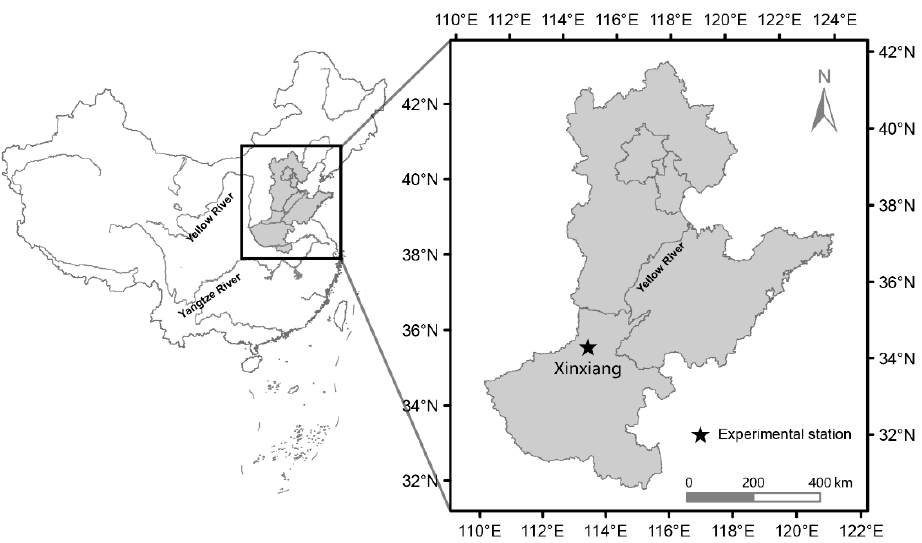
Figure 5. Location of Xinxiang Experimental Station and the North China Plain.